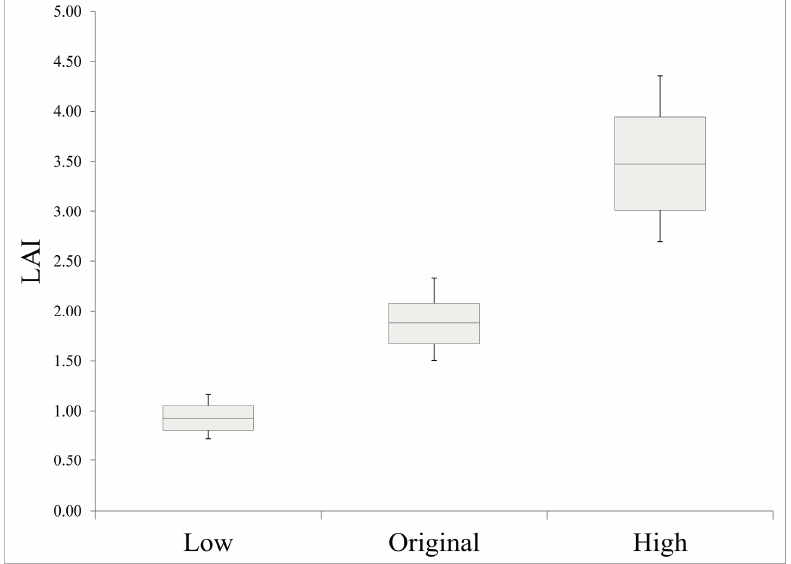
Figure 10. Unthinned P. taeda LAI integrated with the high and low error values for each modified Beer-Lambert input evaluated at each in situ point (n = 21).